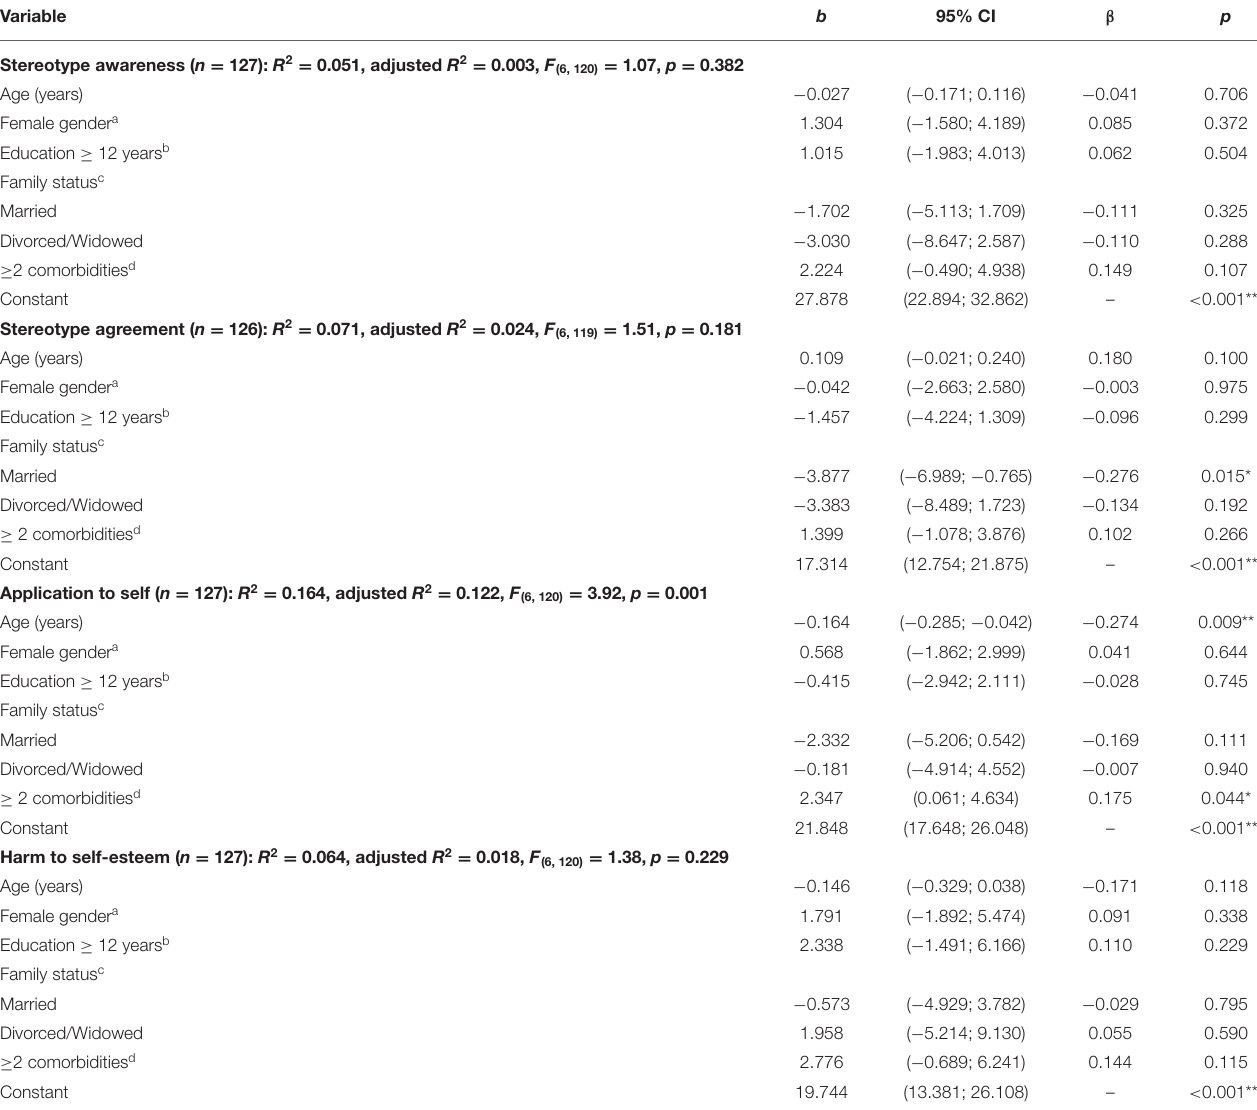
TABLE 5 | Results of multiple linear regression analyses for predicting mental health self-stigma. Variable b 95% CI β